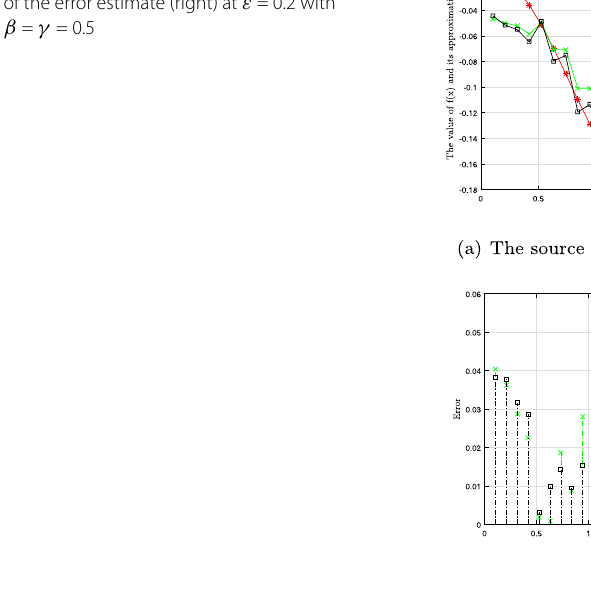
Figure 2 A comparison between the regularized solutions and the sought solution (left), and graph of the error estimate (right) at ε = 0.2 with β = γ = 0.5